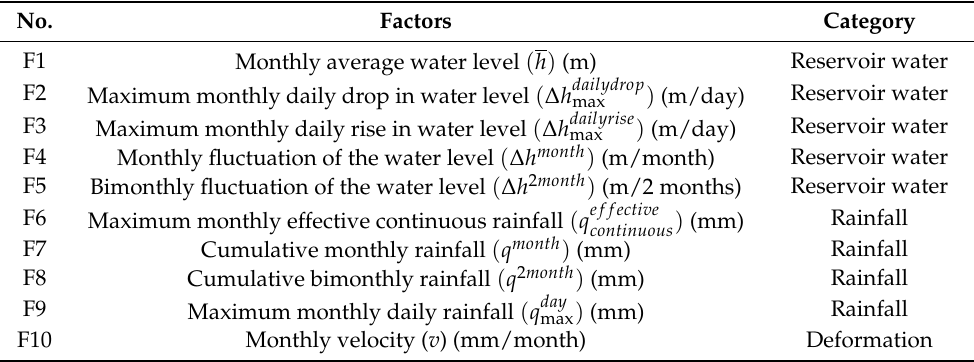
Table 1. Triggering factors used to carry out displacement predictions.